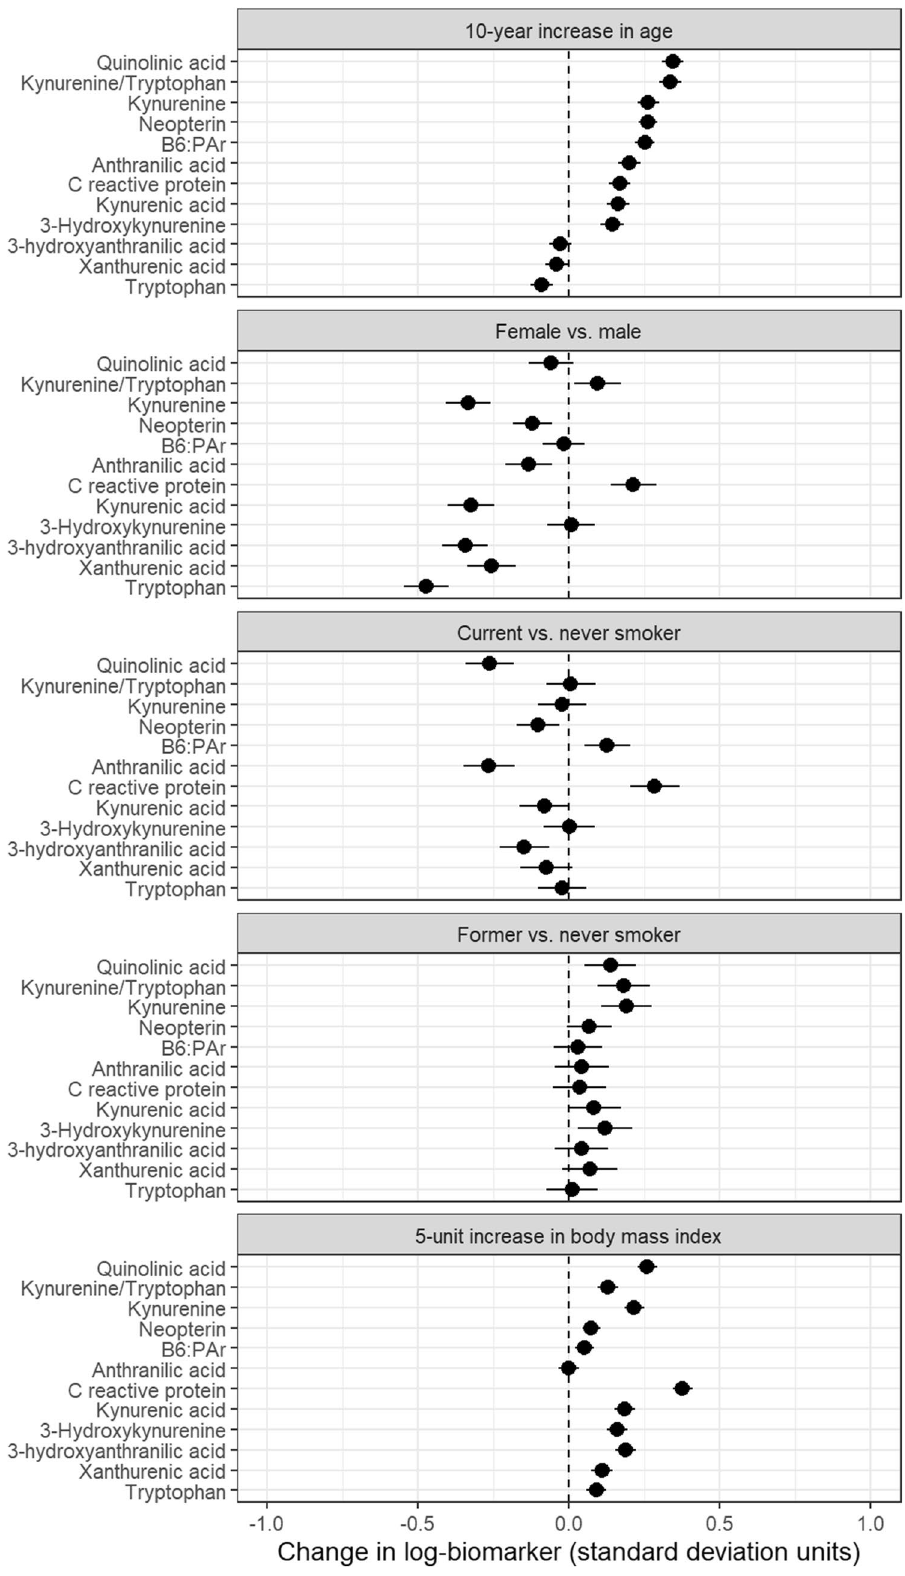
Figure 3. Differences in biomarkers of the kynurenine pathway and inflammation by age, sex, smoking status, and BMI in units of log-biomarker standard deviations, among 5167 control subjects in the Lung Cancer Cohort Consortium. Biomarkers are listed in order of the age